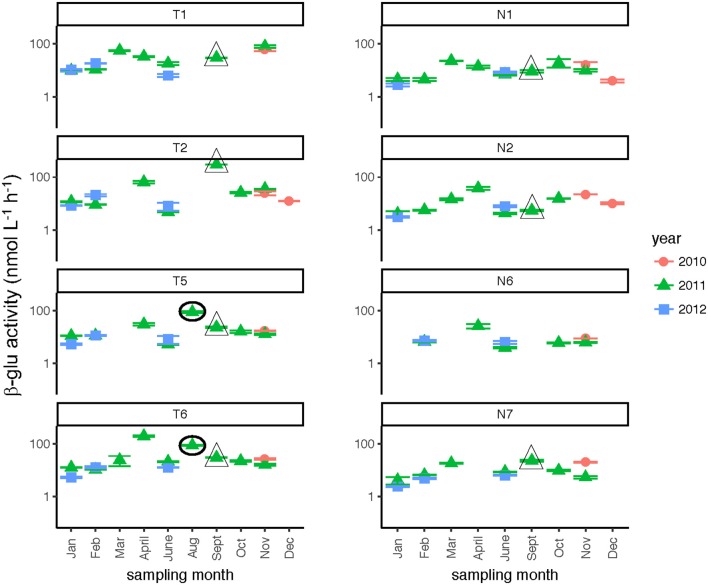
β-glucosidase activities (average and standard deviations) at four stations each in the Neuse and Tar-Pamlico Rivers from 2010 to 2012. “T” corresponds to Tar-Pamlico stations, “N” corresponds to Neuse stations. Symbols outlined with triangles show sampling carried out in the month post Hurricane Irene. Circled symbols (Stns. T5 and T6 only) show samples collected in August 2011, shortly after Hurricane Irene crossed through eastern North Carolina. y-axis is a logarithmic scale.